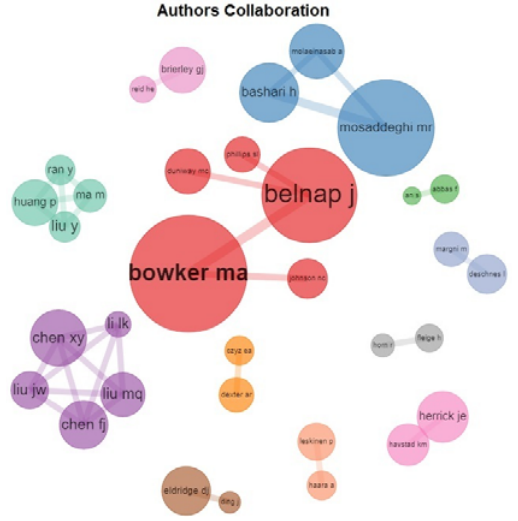
Figure 5. Co-Citation Network.